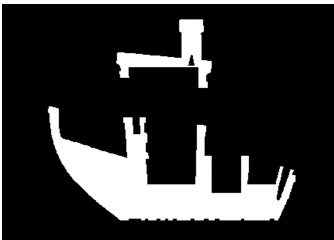
Figure 13. Single cross-section of a “Benchy” model—view displayed by an LCD screen in the LCD–DLP method in the middle of the print.